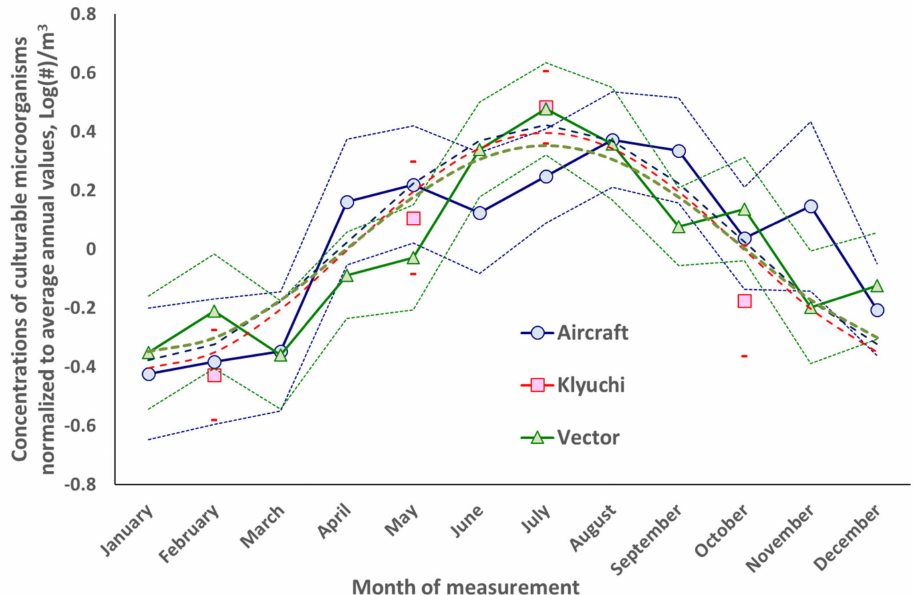
Figure 4. Dynamics of the normalized intra-annual concentration of culturable microorganisms, measured at three locations near the city of Novosibirsk. Explanations are in the text.